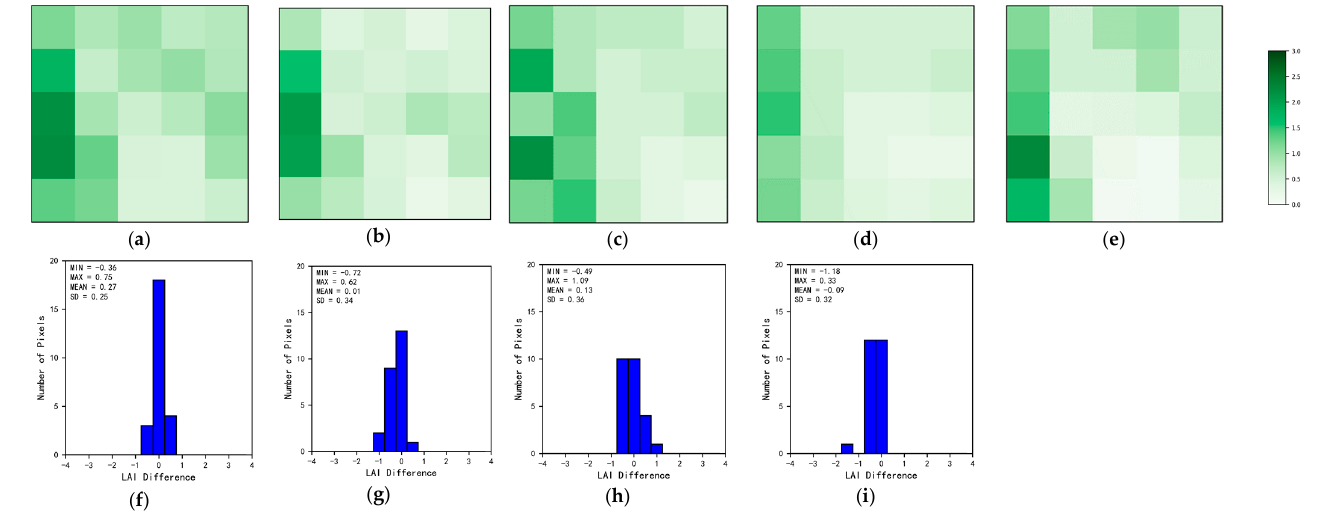
Figure 12. Images of the LAI-TCA ( a ), the LAI-GRNN ( b ), the VIIRS ( c ), the MODIS ( d ) and the LAI values acquired from high-resolution reference maps ( e ) at the 25de_Mayo_Shurb site on Day 40, 2014. ( f – i ) Statistical distributions of discrepancies between the LAI-TCA, the LAI-GRNN, the VIIRS, the MODIS and the LAI values acquired from high-resolution reference maps.